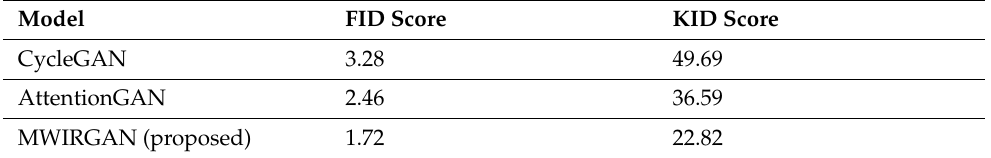
Table 1. Quantitative comparison among different methods. Bold numbers indicate best-performing methods.